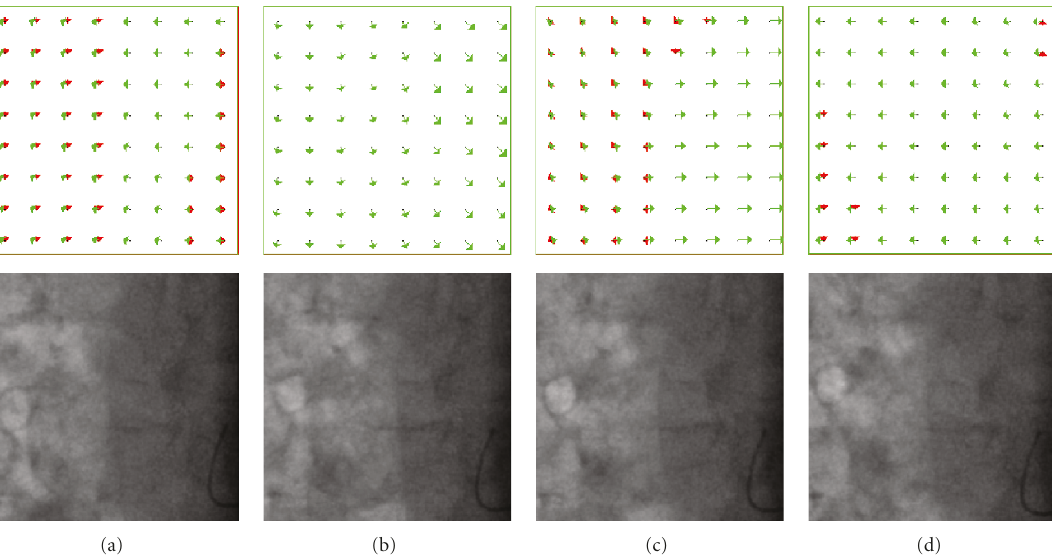
Figure 6: Four-estimated two-layer motion fields, along with the corresponding fluoroscopic image at four di ff erent time instants. One layer corresponds to the static background (ribs) and its estimated a ffi ne model is plotted in red. The other layer involves the heart and the lung tissues and its estimated a ffi ne model is plotted in green. (a), (c) instants are within in the diastole phase, (b), (d) ones in the systole phase.